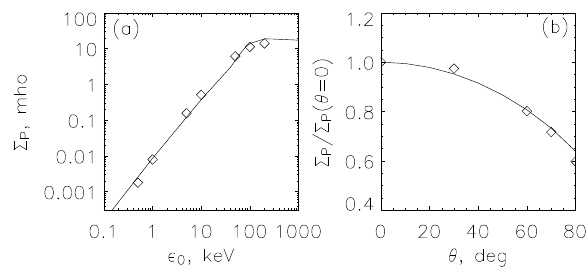
Figure 10: 2007.12.18: Y. Hiraki and C. Tao Fig. 10. Dependences of the height-integrated Pedersen conductiv- ity on initial (a) energy ε 0 and (b) tilt angle θ of electrons. Dia- monds are obtained with Monte Carlo calculation results, while the solid lines are from parameterization (details in